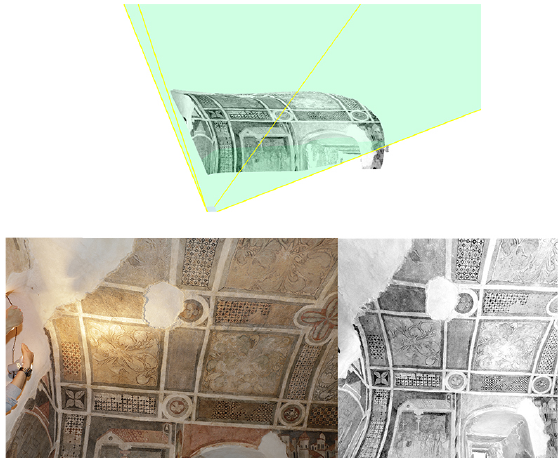
area favoured the points recognition.